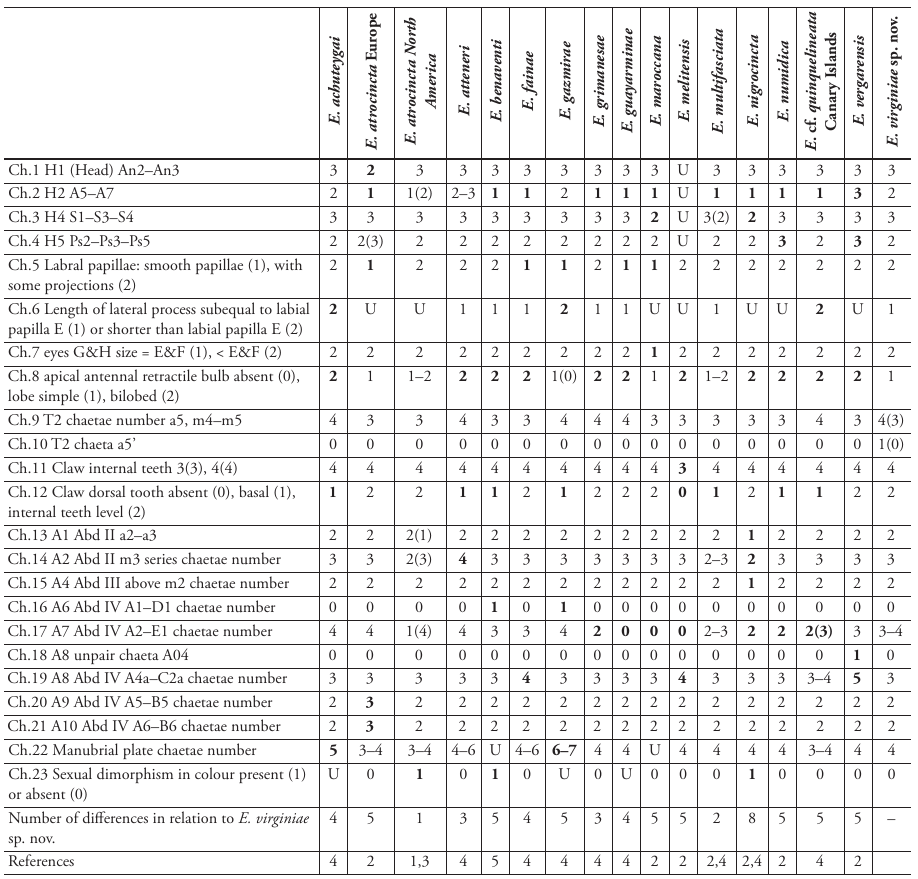
Table 2. Differences of E. virginiae sp. nov. among the similar species of Entomobrya by colour pattern and/or macrochaetotaxy of Th II and Abd II–III tergites. The species share: Mc S’0 on H3 area of head absent; Th II with 2 Mc on T1 area; Abd III with 1/1 Mc on A3/A5 areas; Abd IV without unpair chaetae on A7 and A9 areas and the trichobothrium at the level T2 and T4. U = unknown character. Differences with E. virginiae sp. nov. in bold. References: 1, Christiansen and Bellinger (1998); 2, Jordana (2012); 3, Katz et al. (2015a); 4, Baquero and Jordana (2018); 5, Rueda and Jordana